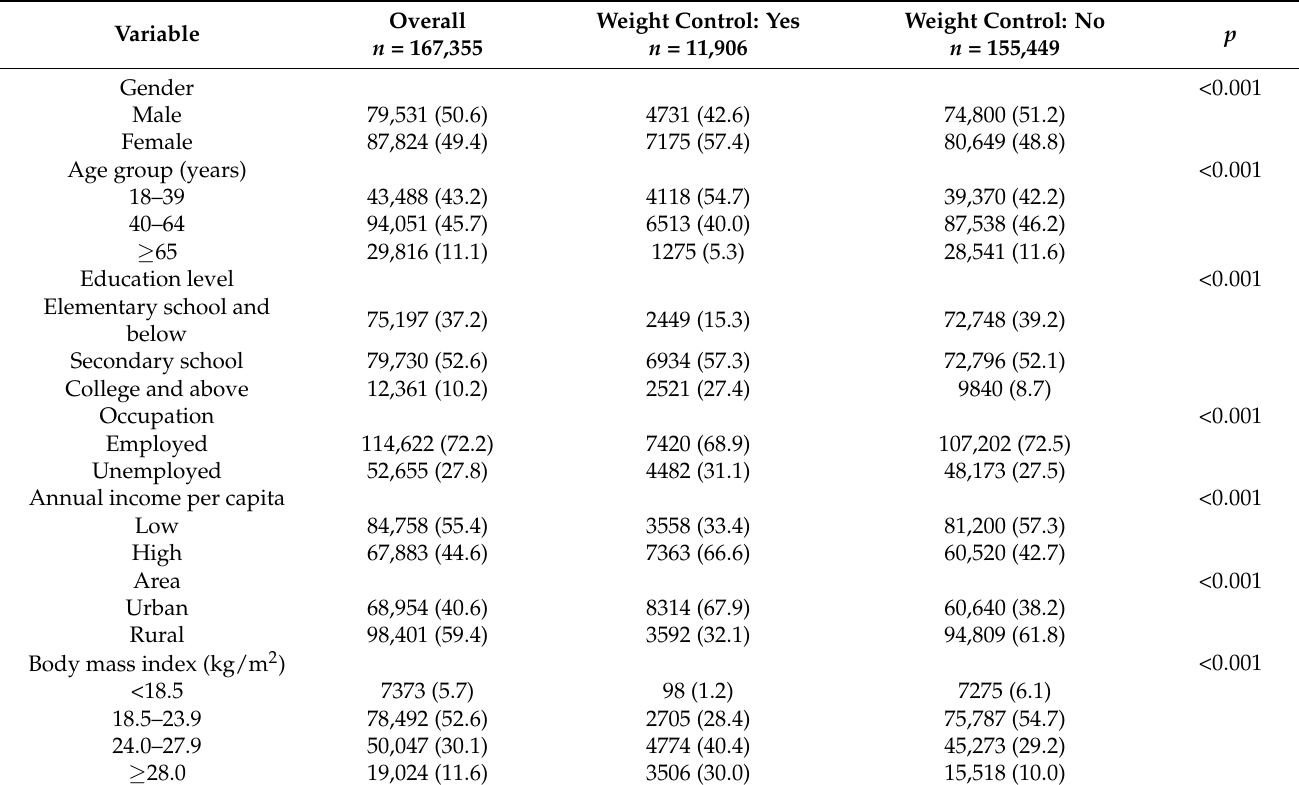
Table 1. Characteristics of Chinese adults in the three rounds of China National Nutrition